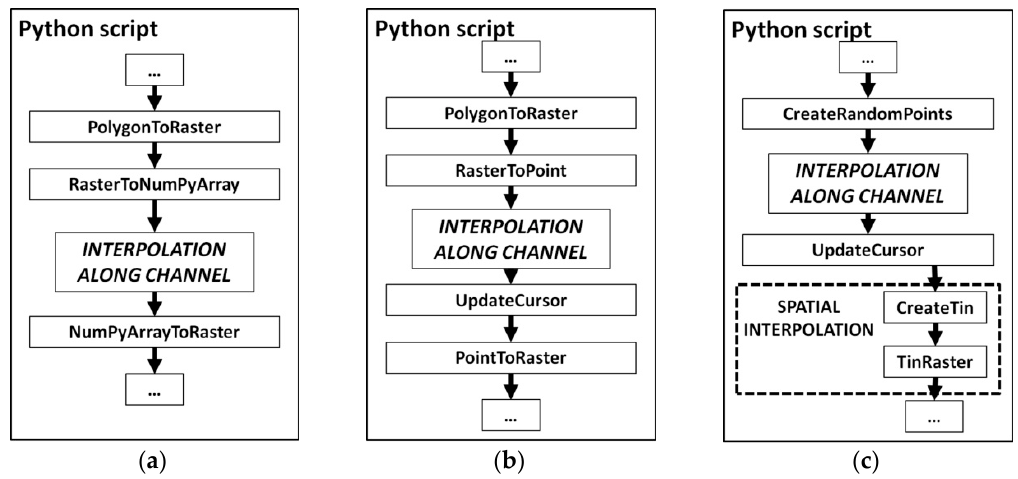
Figure 6. Tested computational schemes: ( a ) the first approach based on NumPy array transformation; ( b ) the second approach based on point–raster transformation; ( c ) the third approach based on random points.